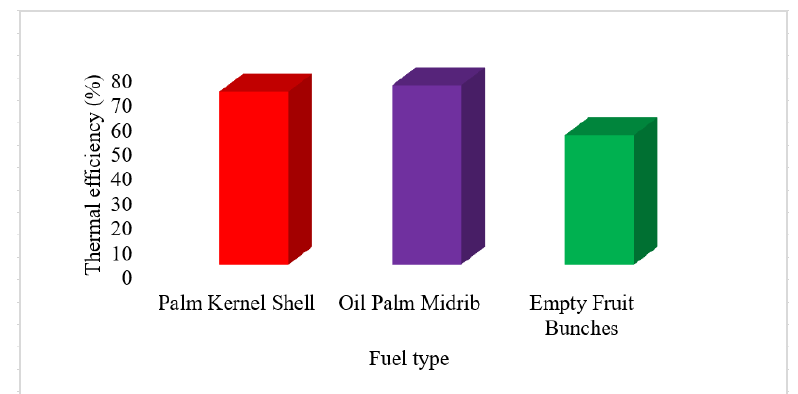
Figure 11. Effect of thermal efficiency for a different fuel.